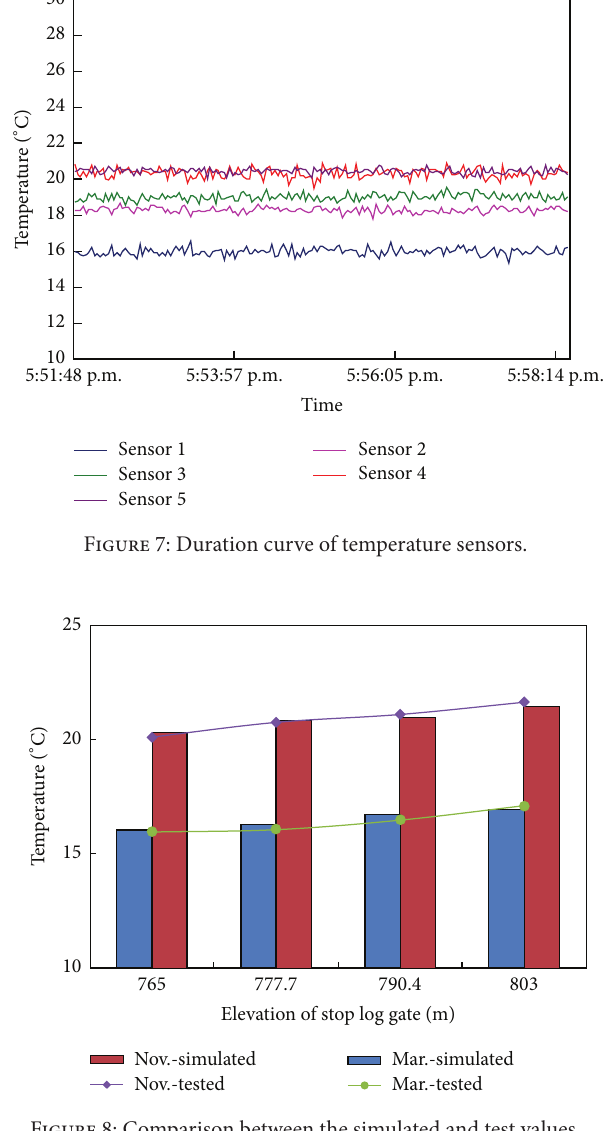
Figure 8: Comparison between the simulated and test